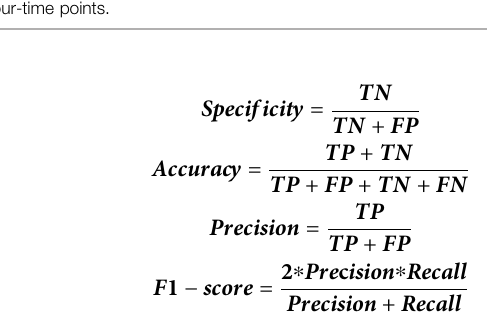
FIGURE3| predictingscoreonday4.Dataareshownasmean. p valuesbytwo-sidedStudent ’ st-test.*: p ＜ 0.05;***: p ＜ 0.001. (G) SchematicdiagramofCellpro fi ler software for cell localization and cell morphology capture. (H) Cell morphology was measured on the cell images of the validation dataset of 0, 1, 4, and 7 days using CellPro fi ler software (United States), and six representative morphological parameters were selected: area, perimeter, aspect ratio (shape); contrast, correlation, and entropy (texture). Box plots were used to observe the differences between the BA/OS groups on the six parameters. (I) ROC curves of deep learning, support vector machines (SVM), and six parameters, comparing the classi fi cation performance of four-time